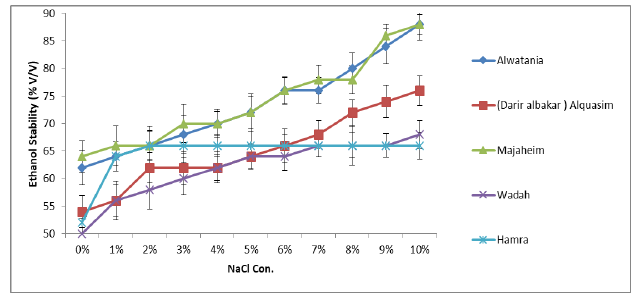
Figure 1. Effect of sodium chloride concentration (%: g/100 g) on ethanol stability of camel milk samples—Alwatania, Alquasim (Darir alabakar), Majaheim, Wadah, and Hamra (ethanol stability: % (vol/vol). Error bars indicate the standard deviation.